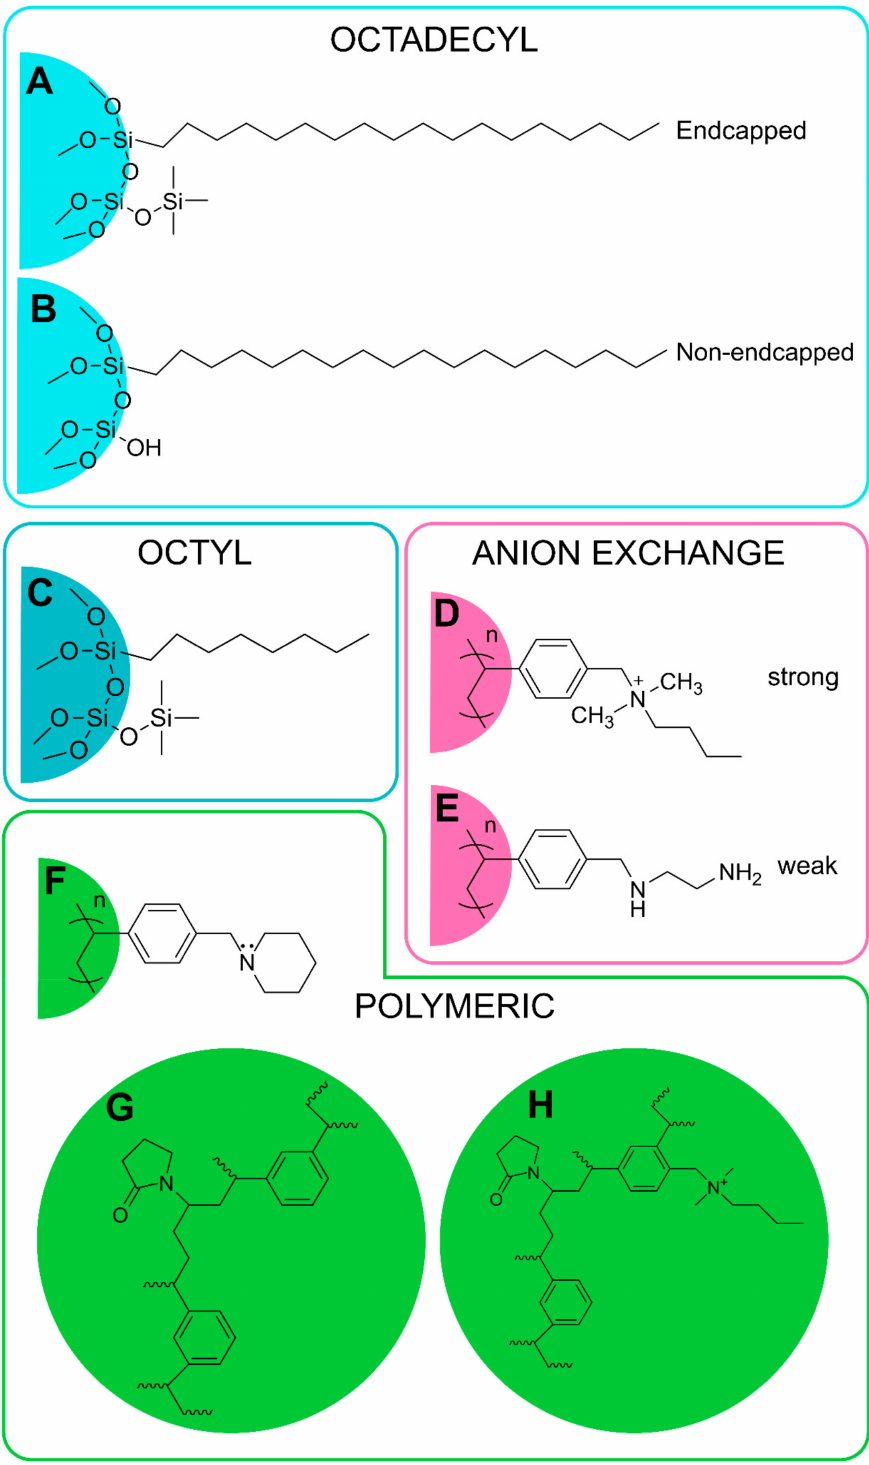
Figure 3. Examples of the most commonly used types of solid-phase extraction (SPE) phases for oxylipin extraction. A: Strata C18-E; B: Chromabond C18; C: Discovery DSC-8; D: Strata-X-A; E: Strata-X-AW; F: Strata-X; G: Oasis HLB; H: Oasis